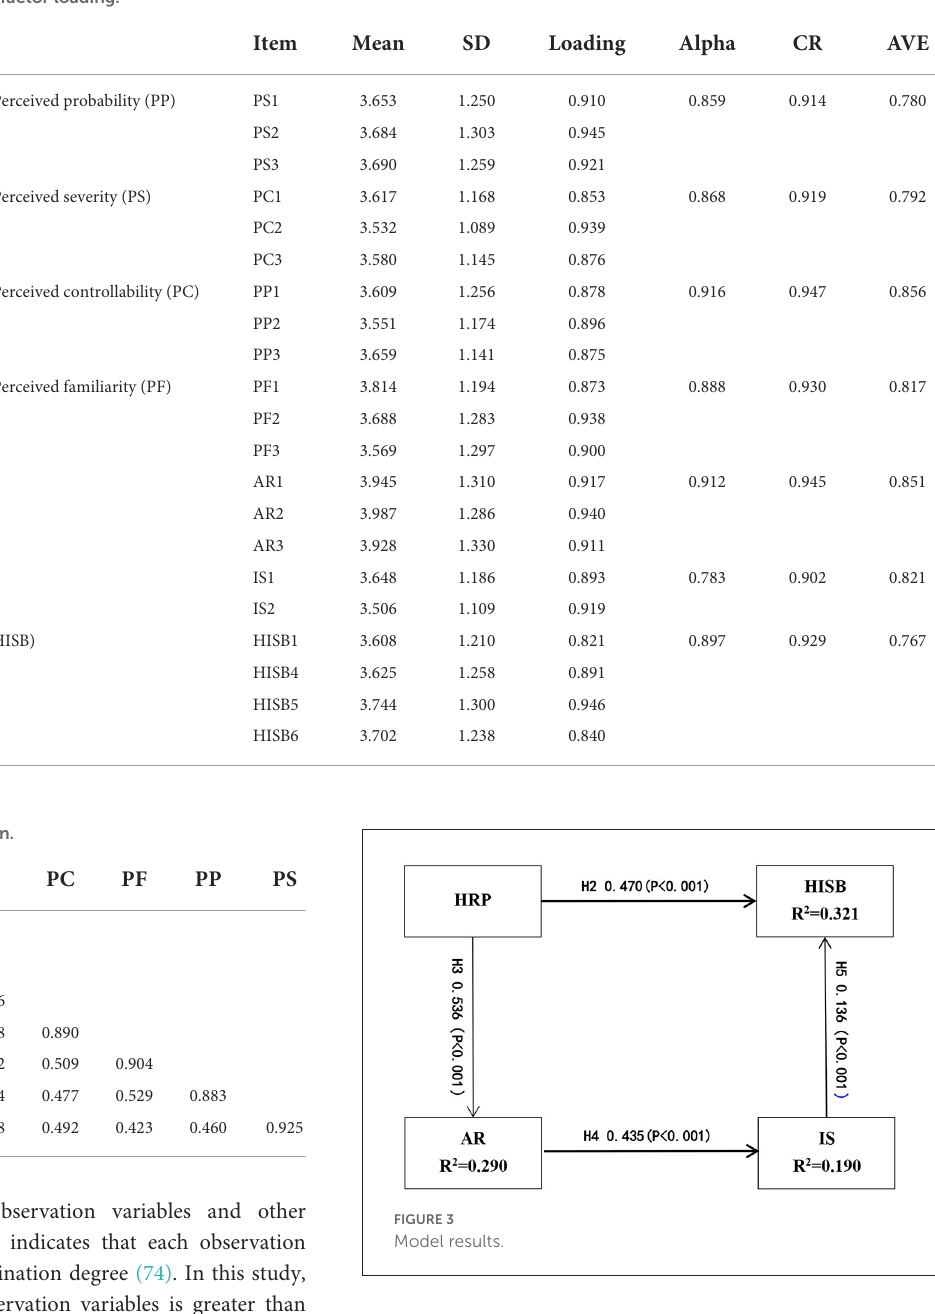
TABLE 5 Reliability, validity, and factor loading.